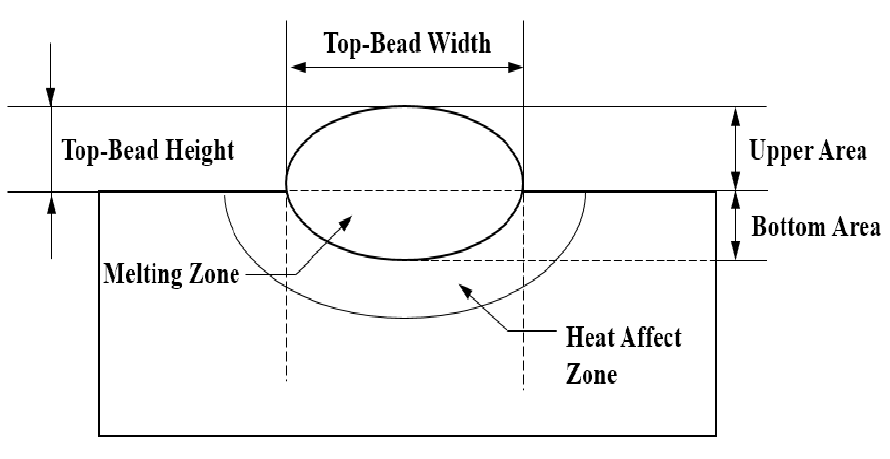
Figure 3. Schematic diagram of bead geometry [7].